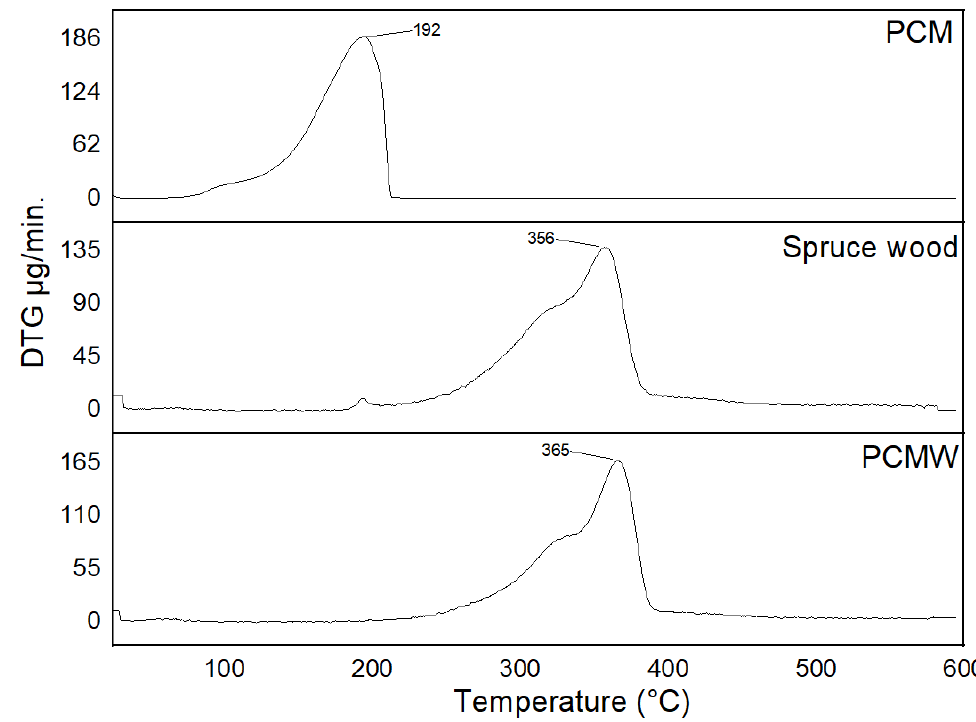
Figure 5. DTG of the PCM (n-HD)- and PCM-impregnated wood